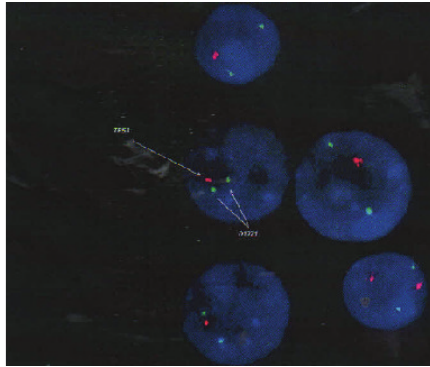
Figure 2: FISH analysis of TP53 (red